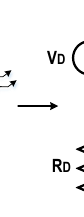
Figure 2. Flyback model in DCM for the LFAA.